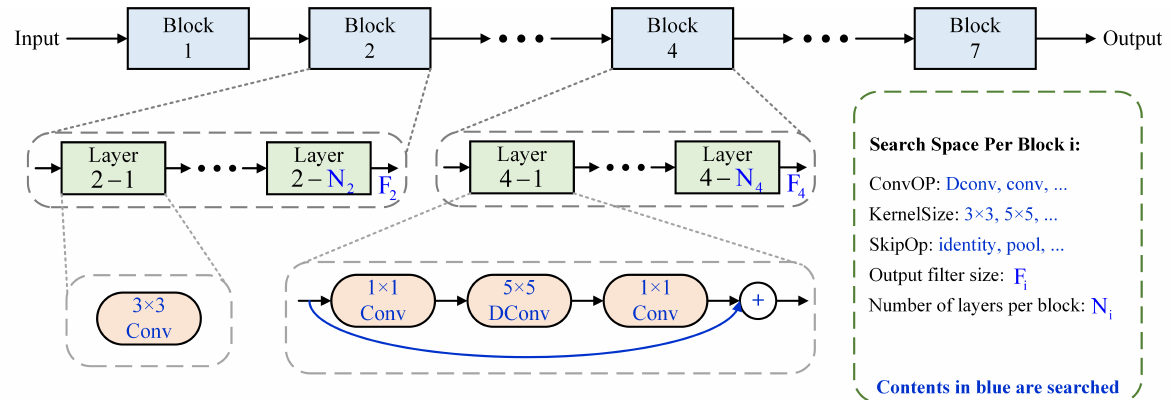
Figure 36. Factorized Hierarchical Search Space. Convolutional ops (ConvOP): regular conv (conv), depthwise conv (dconv), and mobile inverted bottleneck conv with various expansion ratios. Convolutional kernel size (KernelSize). Skip operations (SkipOp): max or average pooling, identity residual skip, or no skip path.